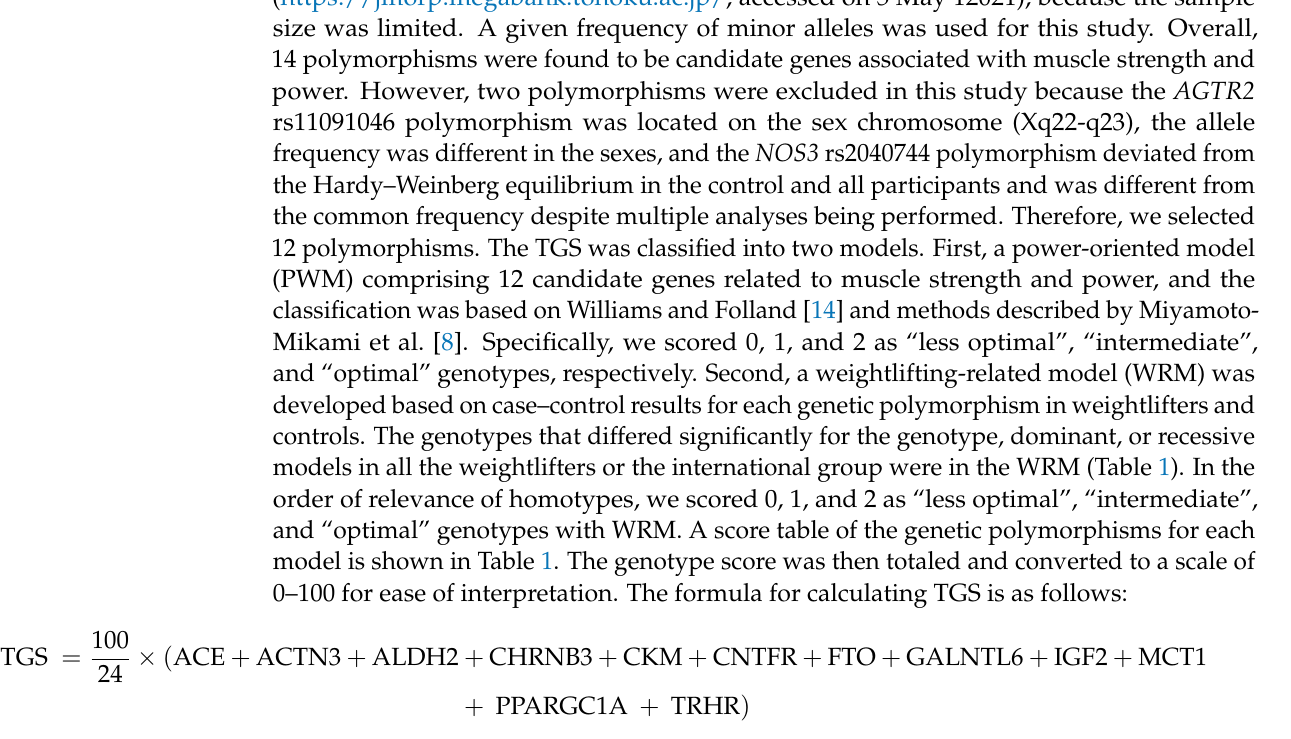
Table 1. Polymorphisms of each model in